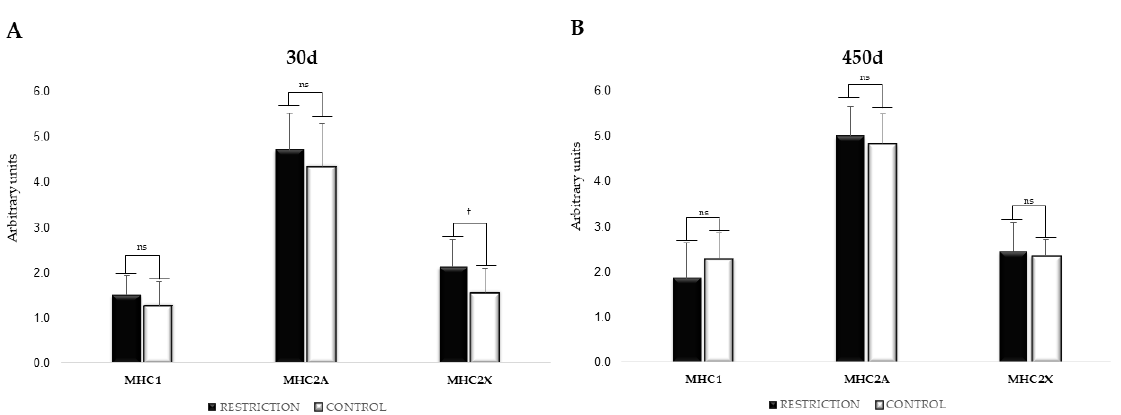
Figure 4. Relative gene expression (means ± SEM) of Myosin Heavy Chain (MHCs) isoforms in the skeletal muscle of the offspring resulting from maternal protein restriction and control group evaluated at 30d ( A ) and 450d ( B ); ns = not significant ( p > 0.10); † tendency when 0.10 < p >